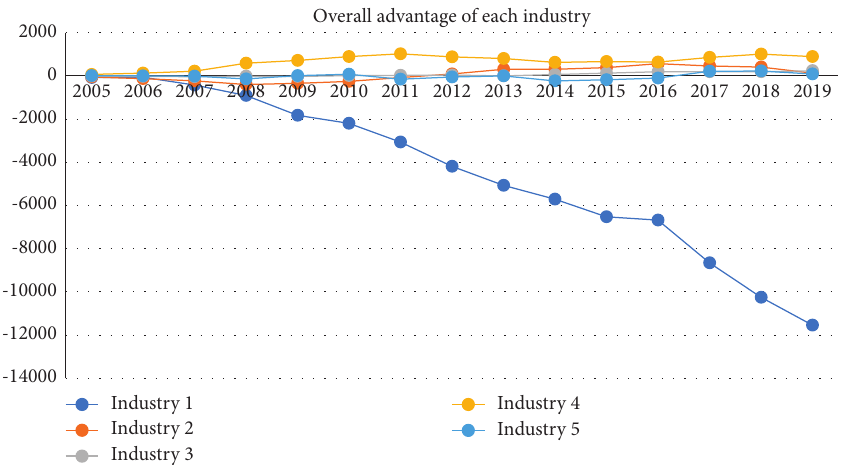
Figure 9: Overall advantage of each